Question: What visual encoding does this figure use to show its data?
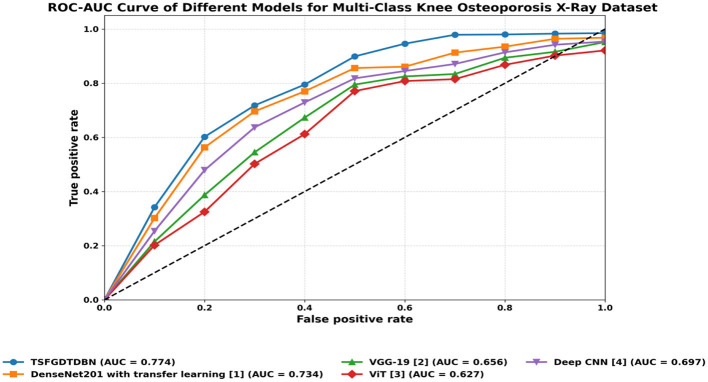
Answer: line